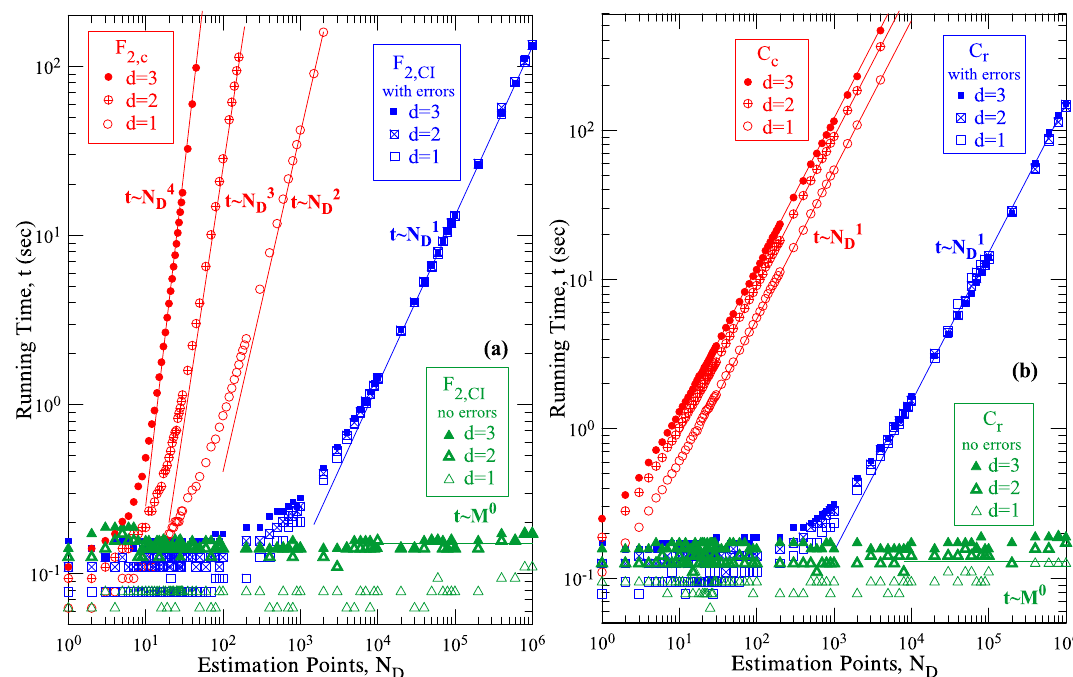
Fig. 3 The running time for F 2 in a and C in b and for different techniques as function of the estimation points N D , for fixed N m = 10 and N